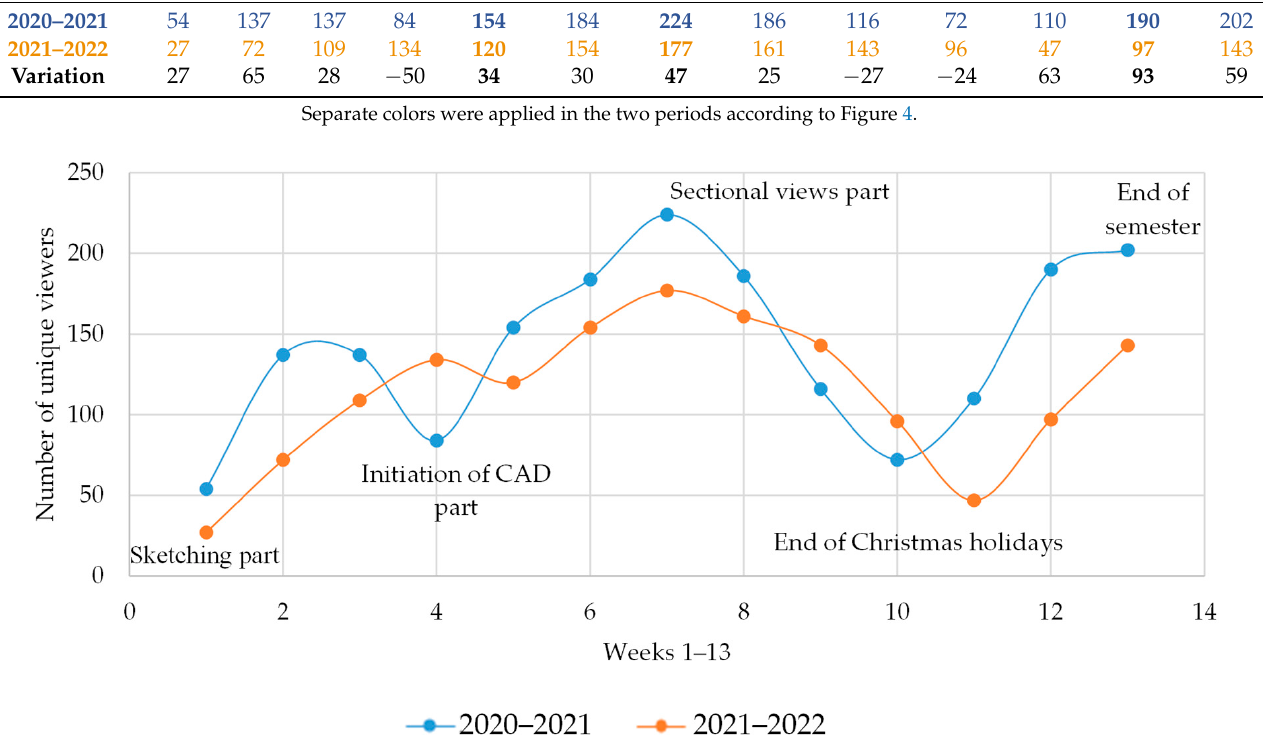
Figure 4. Chart of unique viewers per week. Separate colors were applied in the two periods ac- cording to Table 3.